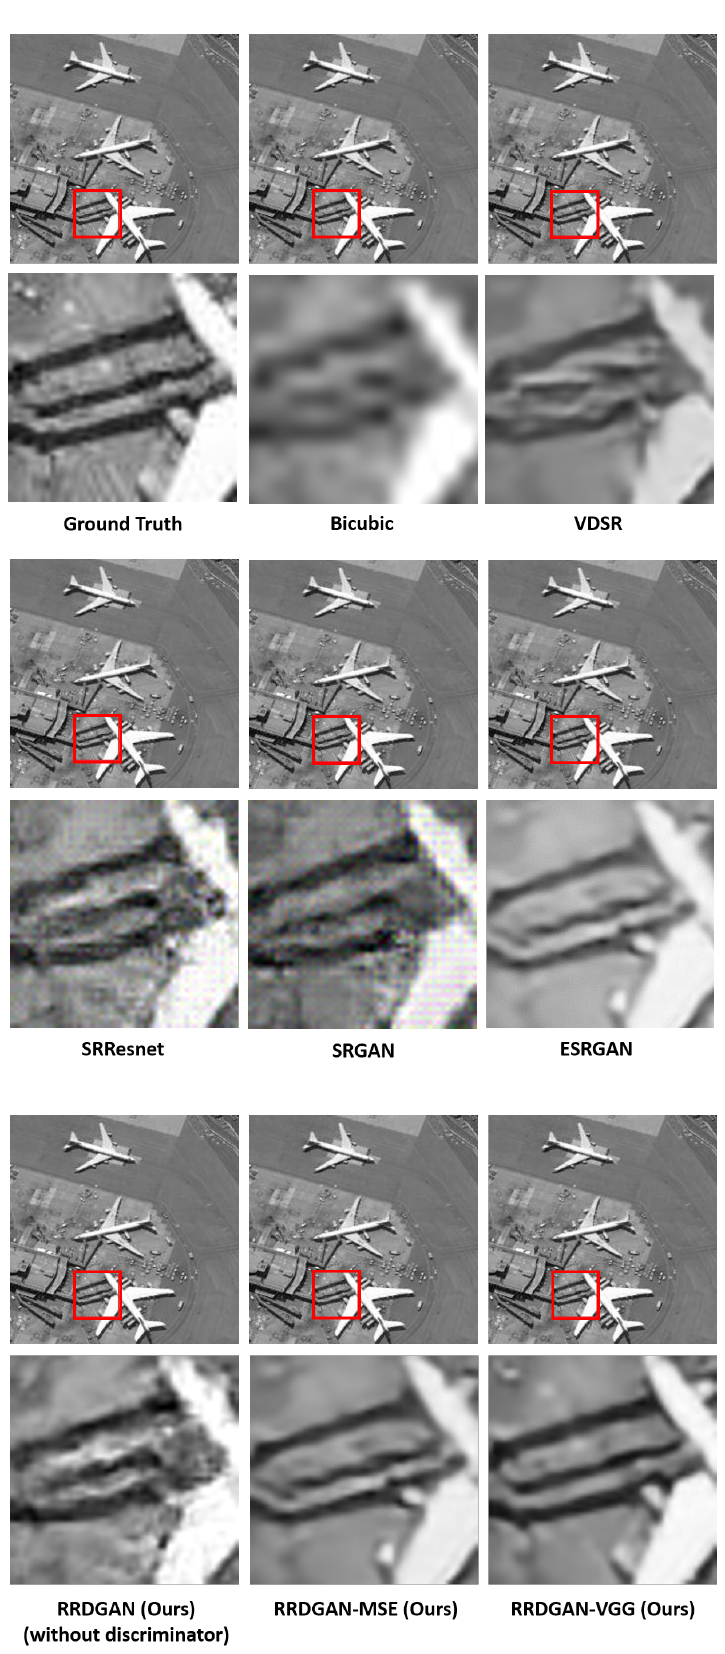
Figure 7. Comparison results among different methods of “Airplane”, scale factor is